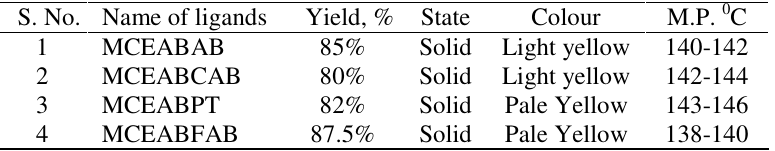
Table 1. Physical characteristics of the ligands